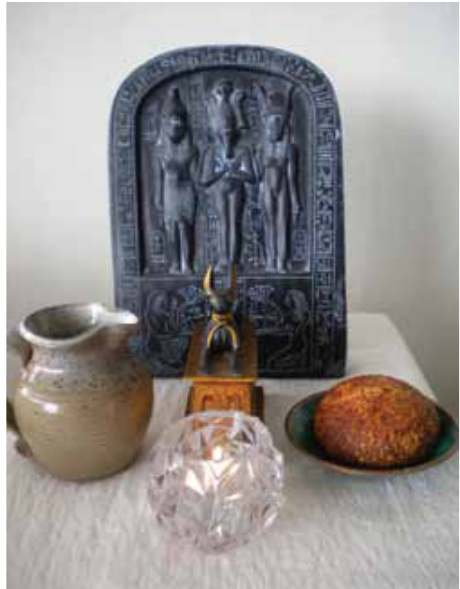
Fig. 3: Modern replica items, consecrated for ritual use: (c) Richard J. Reidy, The Temple of Ra, San Francisco, provided for Paul Harrison